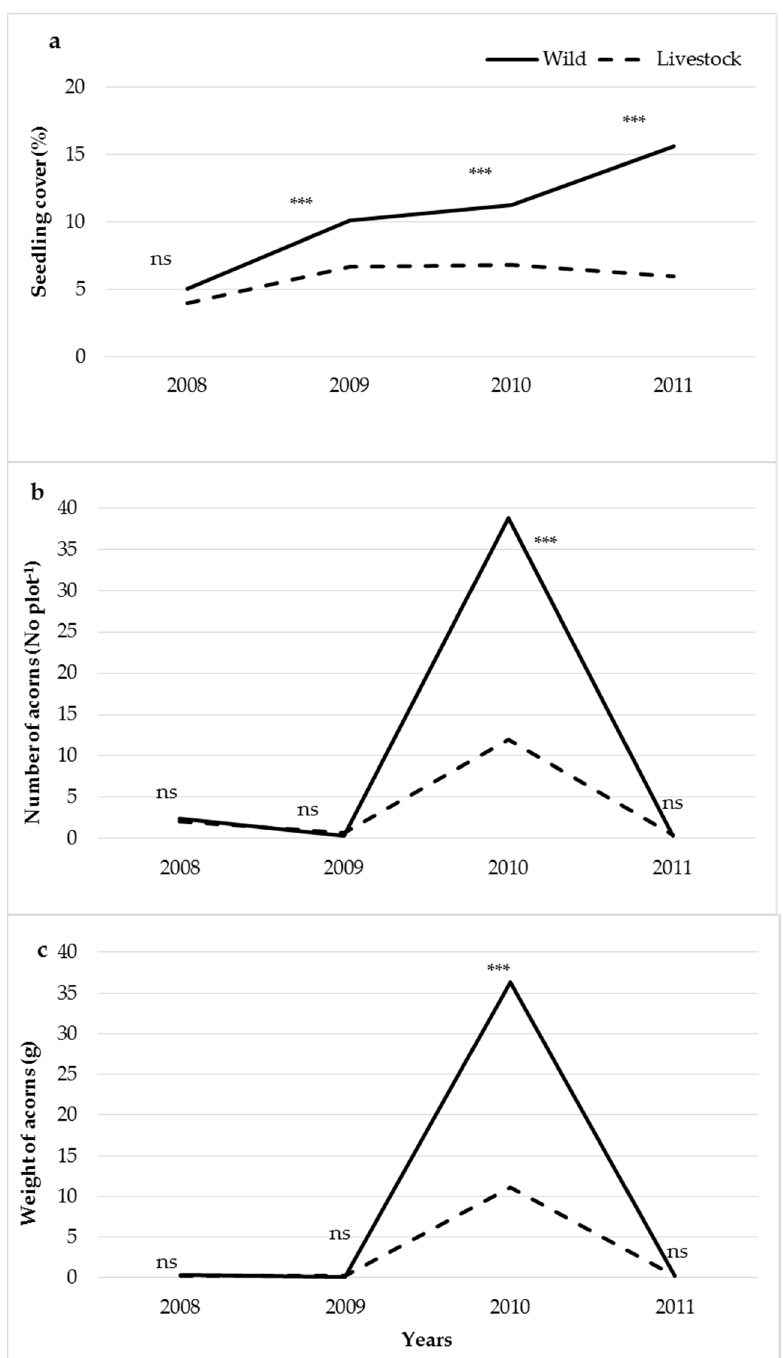
Figure 1. Interaction between years and type of users for ( a ) seedling cover, ( b ) number of acorns, and ( c ) weight of acorns.